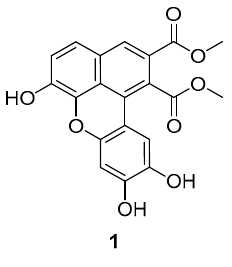
Figure 1. Structure of compound 1 .